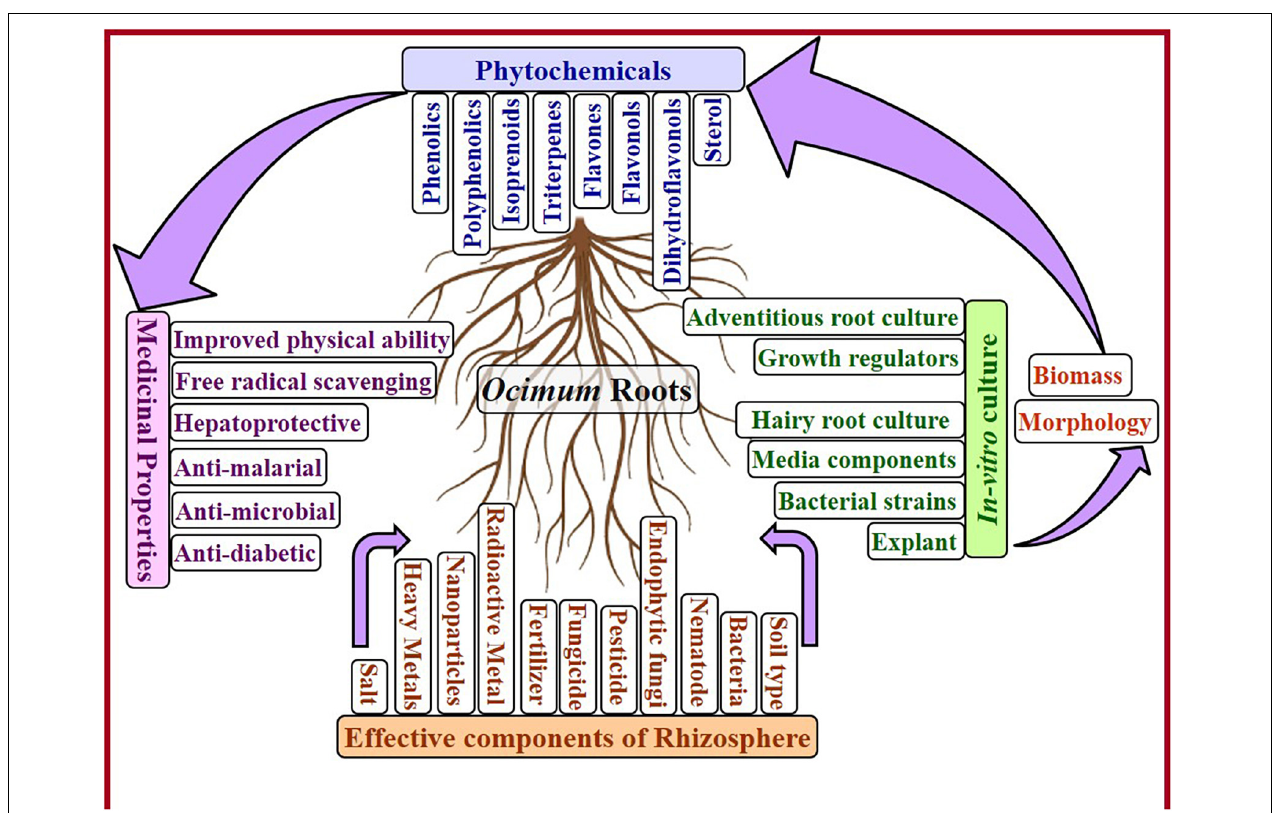
FIGURE 1 | Factors affecting Ocimum root growth and its